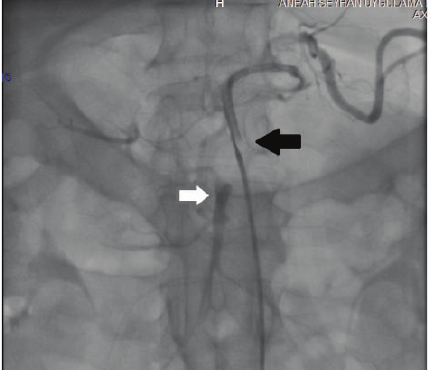
Figure 3: Flows in CA, SA (black arrow), and SMA (white arrow) following deployment of balloon expandable stent.